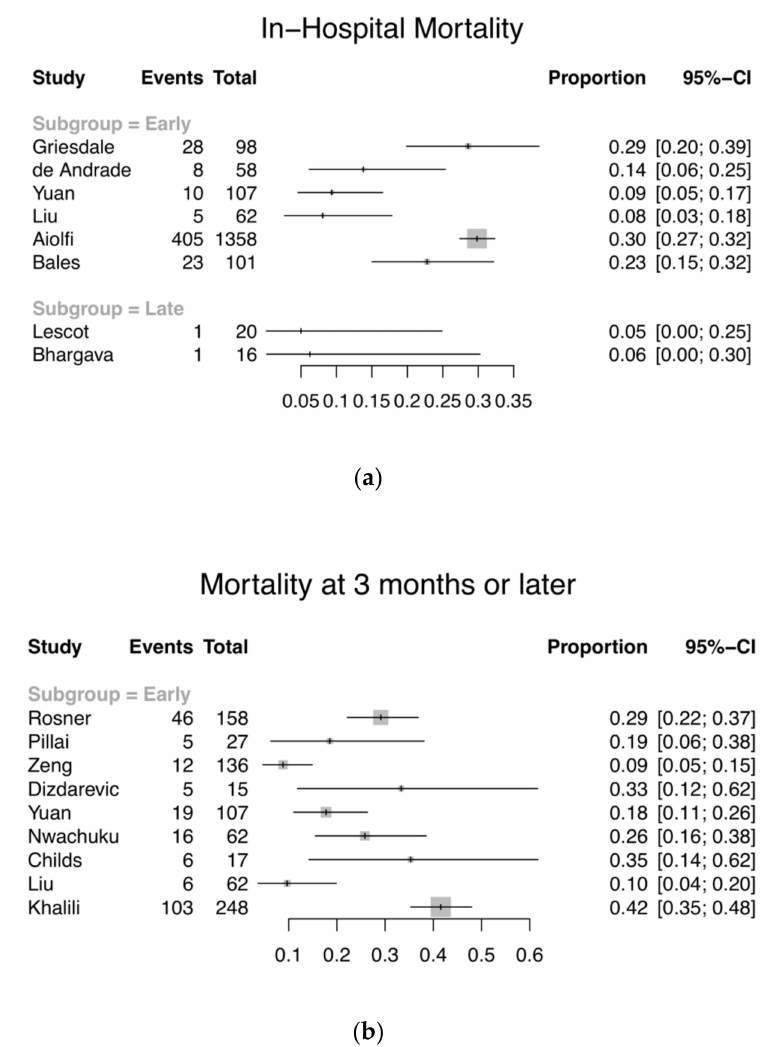
Figure 2. Forest plots showing the proportion and 95% confidence intervals (CI) of ( a ) in-hospital mortality; and ( b ) mortality at 3 months or later for individual studies, stratified by time of EVD insertion. (Studies in the late EVD group did not report mortality at 3 months or